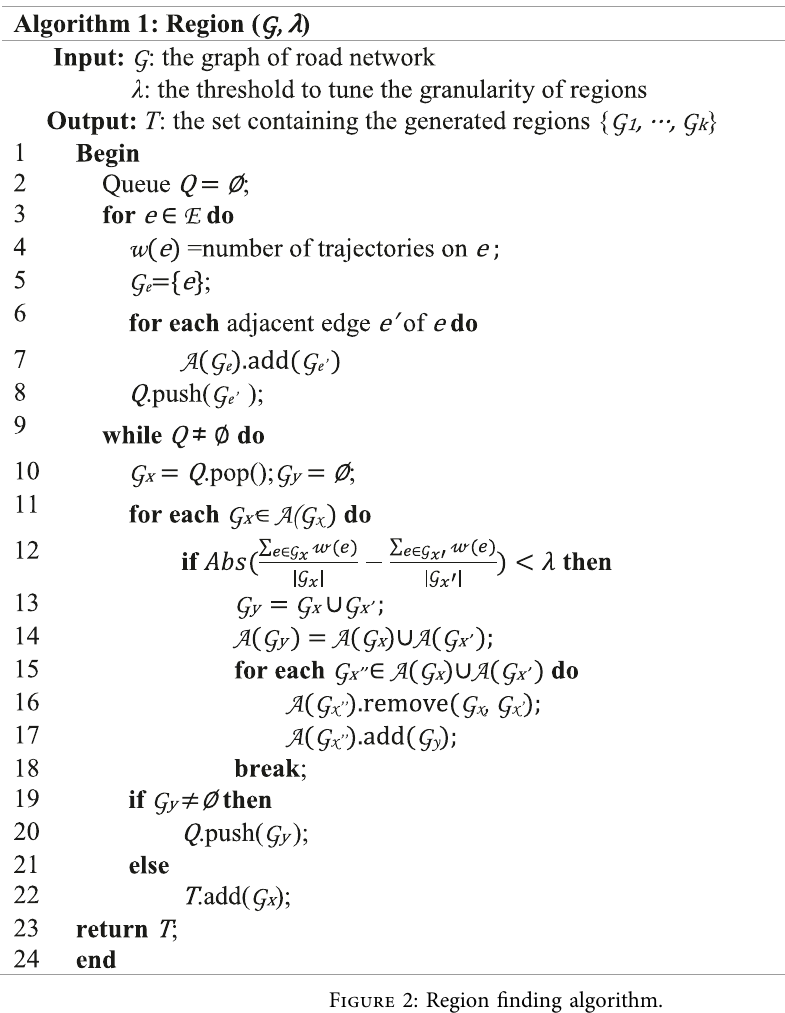
Figure 2: Region finding algorithm.